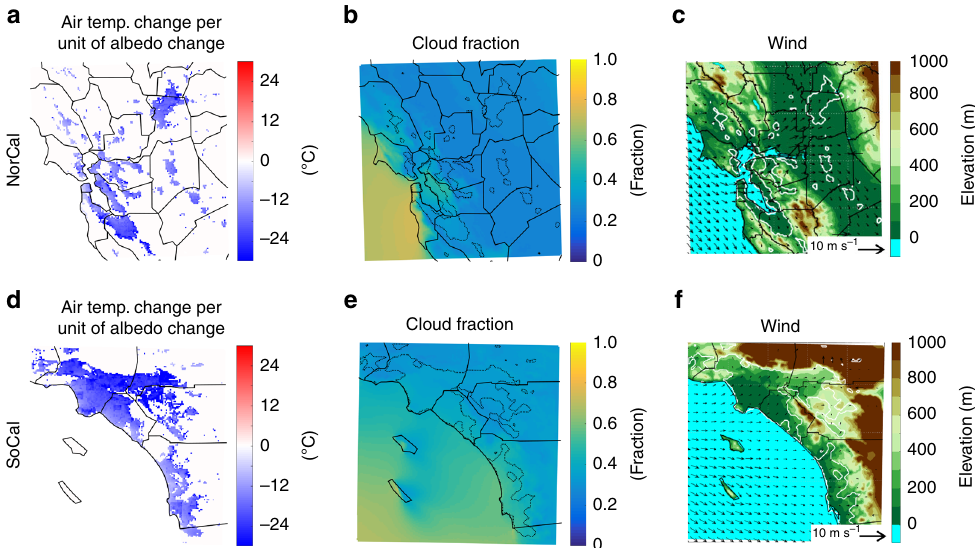
Fig. 5 Spatial distribution of cool-roof-induced changes in air temperature per unit of albedo change and its drivers. a , d Simulated cool-roof-induced changes in 2-m air temperature per unit of albedo change. b , e Simulated cloud fraction and c , f 10-m wind vectors over elevation map for control simulations. Values represent averages over June – October of 2001 – 2015 for NorCal ( a , b , c ) and SoCal ( d , e , f ). The solid black lines illustrate the boundaries of the 18 urban counties that are captured in the model domains. The boundaries of urban surfaces are illustrated by dotted black lines in a , b , d , e and by white lines in c , f . Note that only changes that are statistically distinguishable from zero at 95% con fi dence interval are included in a ,